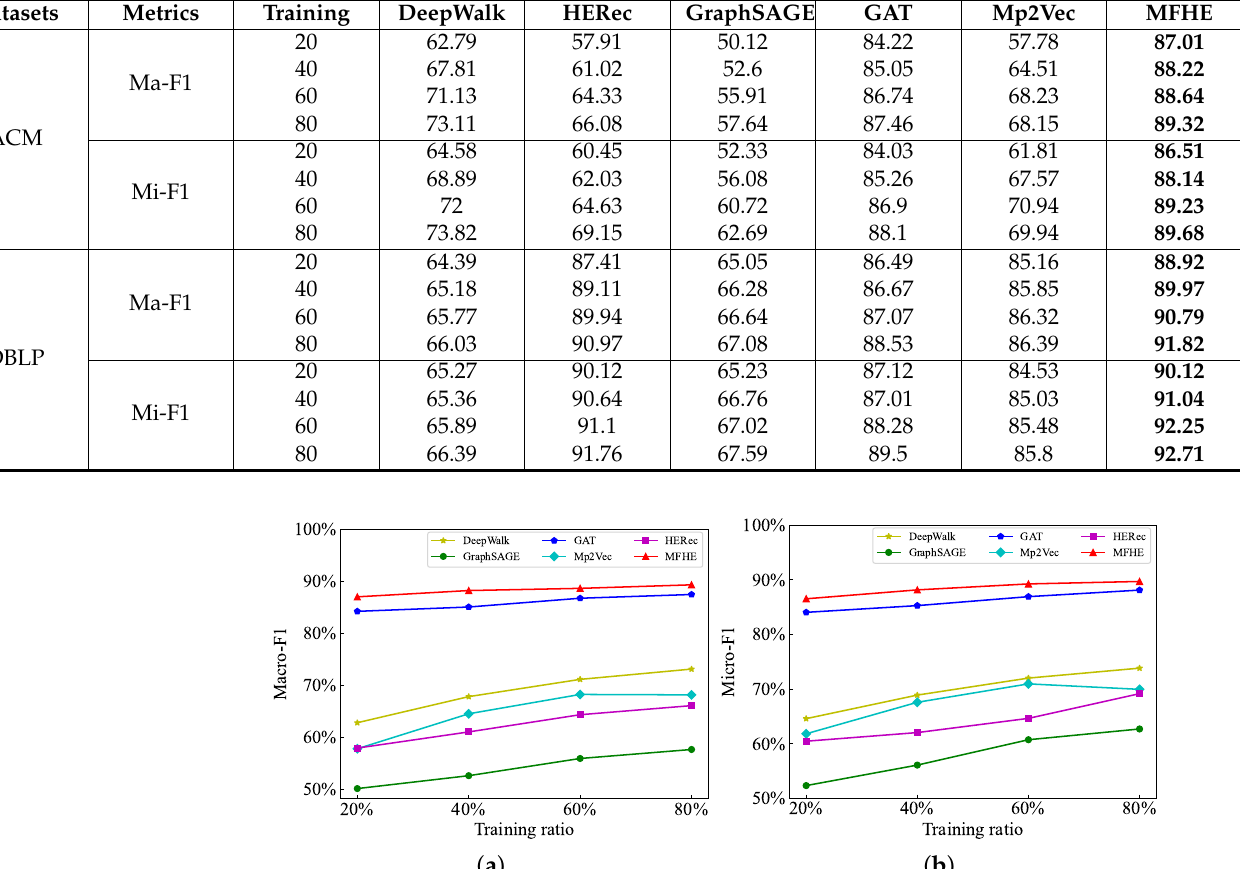
Figure 5. Node classification results on the ACM dataset. ( a ) Macro-F1. ( b ) Micro-F1.